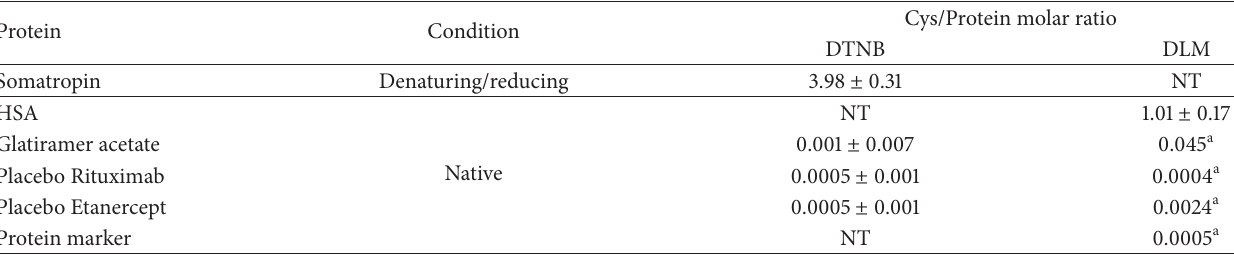
Table 4: Specificity and accuracy of thiol analysis. Controls are specified for DTNB method and DLM method. Protein